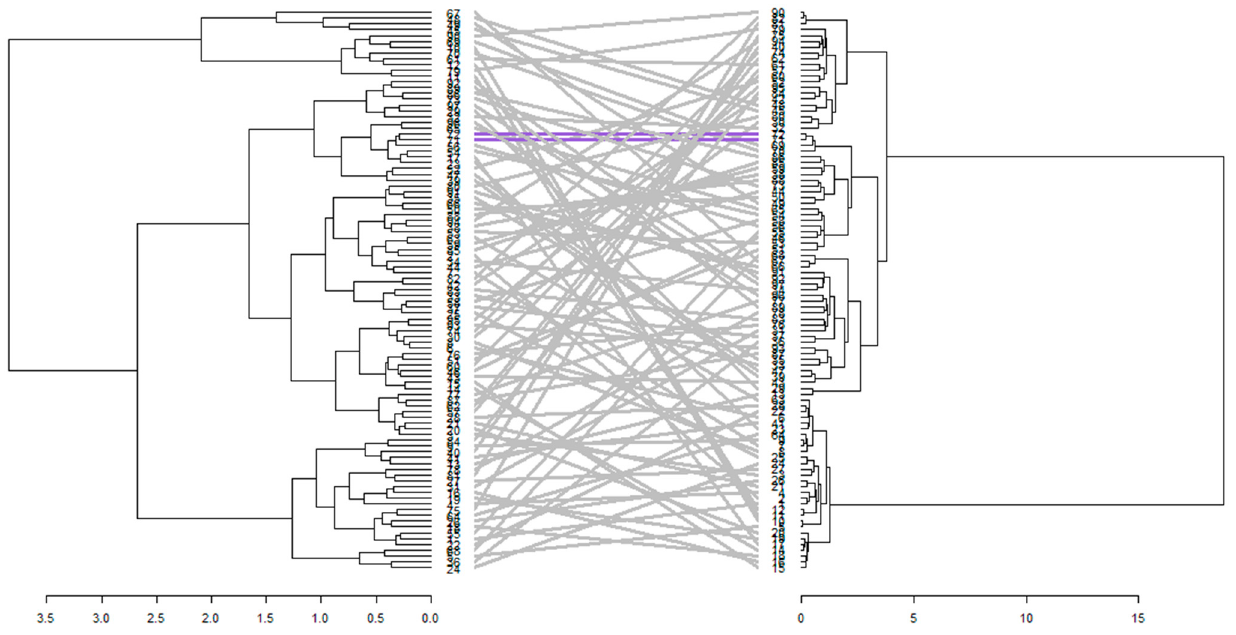
Figure 5. Tanglegram comparison of genotypic and phenotypic hierarchical clusters of 97 wheat genotypes based on 16,382 SNP markers and phenotypic data measured under drought-stressed conditions.